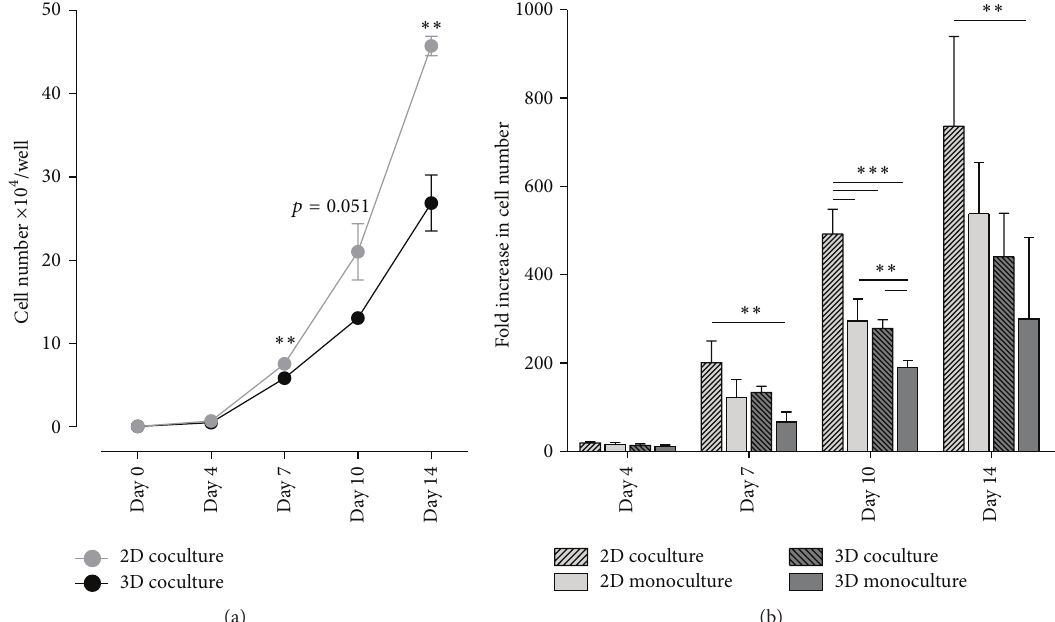
Figure 5: HSPCs proliferate more extensively in coculture with MSC monolayers than with MSC spheroids. Expansion of HSPCs under 2D or 3D conditions was compared by seeding 500 HSPCs in combination with 5000 MSCs in conventional 96-well culture plates or in hanging drop plates, respectively, followed by determination of HSPC numbers at different time points. (a) Representative data from one donor show a significantly lower proliferation rate already after one week of coculture in 3D when compared with 2D. Samples were analyzed in triplicate. Statistical analysis was performed using a two-tailed parametric 𝑡 -test. (b) The fold increase in HSPC numbers was obtained after expansion of 500 HSPCs in coculture or in monoculture. The highest proliferation rates were detected for the 2D coculture, whereas HSPCs incubated with MSC spheroids in 3D did not exceed the expansion level of the 2D monoculture. Statistical significance was assessed using one-way ANOVA. Data are shown as mean ± standard deviation of four independent experiments with four donors ( ∗∗ 𝑝 < 0.01 ; ∗∗∗ 𝑝 < 0.001